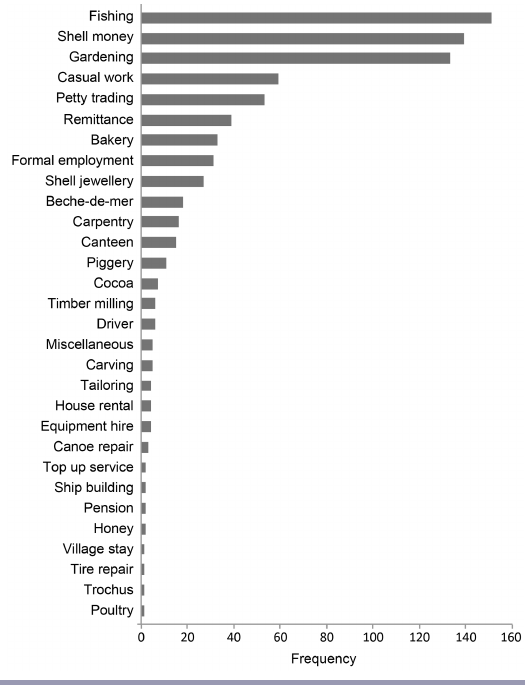
and their frequency among the 235 surveyed households.